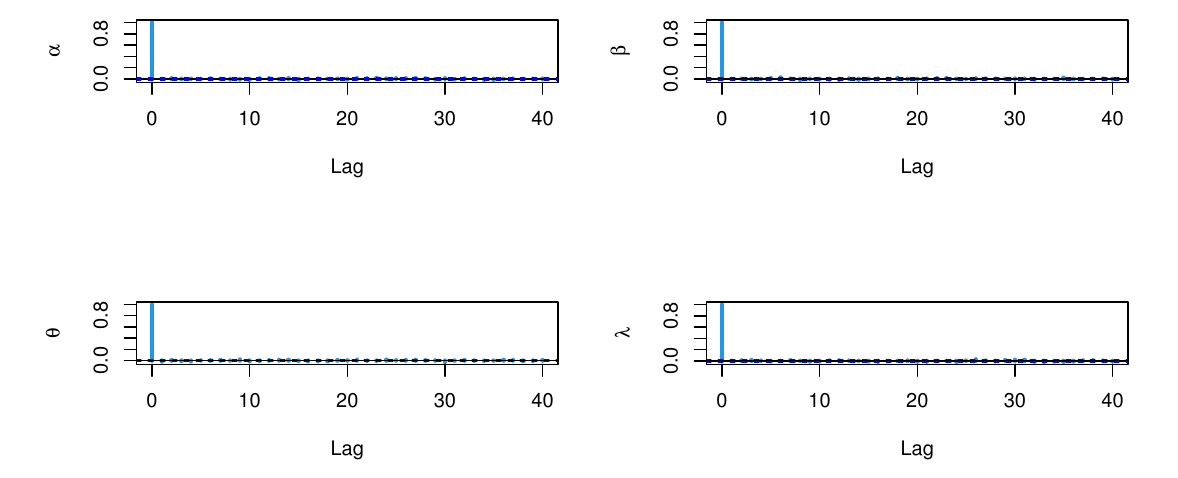
Figure 10. ACF test plots for parameters of TLMW model for COVID-19 data.